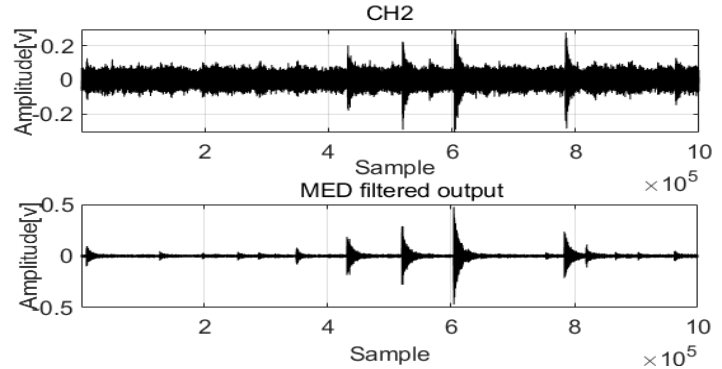
Figure 3. MED method for the acoustic signals in Channel 2. The acoustic signals of Channel 1 and Channel 2 installed at two positions in the pipeline are saved with the noise and feature impulse data. MED successfully used a max- imization kurtosis norm in filtering to remove noise from the mixed signals. After MED processing, the feature impulse signals are easily detected for damping frequency energy processing.